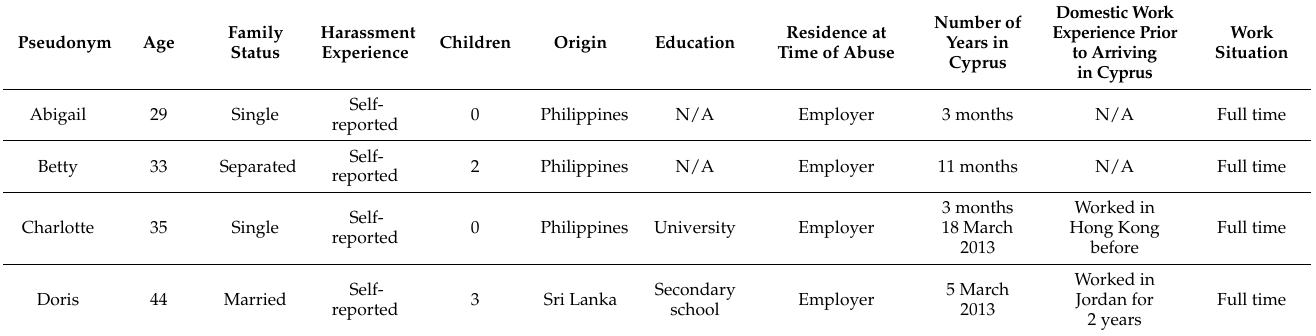
Table 1. Participant demographic